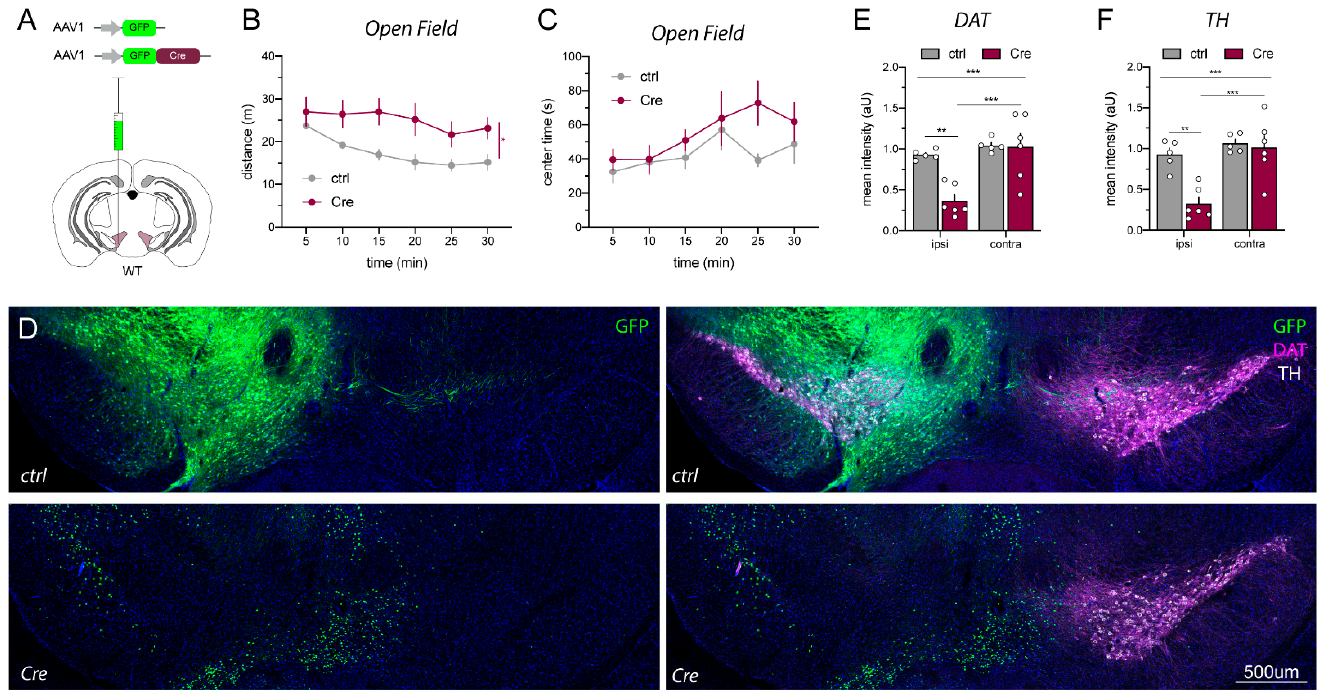
Figure 4. DAT and TH loss in the VTA of AAV1_Cre-GFP-injected WT mice coincide with hyperactivity. ( A ) Scheme visualizing unilateral injection of Cre (AAV1_Cre-GFP) and AAV1_GFP controls at 10 13 GC/mL into the VTA of adult WT C57BL/6J mice (for details see Figure S1). ( B , C ) Cre-injected WT mice become hyperactive compared to GFP control-injected mice in the open field (ctrl n = 5, Cre n = 6; mixed-effect analysis, distance: F(2.327,20.47) = 8.179, p = 0.4653 and genotype: p = 0.0465 *, center time: F(5,45) = 1.380, p = 0.2498 and genotype: p = 0.2969). ( D ) Immunostainings of unilaterally injected WT mice with either AAV1_GFP (ctrl; top panels) and AAV1_Cre-GFP (Cre; bottom panels) four weeks after injection. ( E , F ) Quantification revealed a massive loss of TH (white) and DAT (magenta) in the ipsilateral (ipsi, injected) side of Cre-injected mice compared to the contralateral (contra, non-injected) side and AAV1_GFP control-injected mice (ctrl n = 5, Cre n = 6; two-way ANOVA, DAT: F(1,9) = 12.12, p = 0.0006 ***; ipsi ctrl vs. Cre p = 0.0019 **; Cre ipsi vs. contra p = 0.0003 ***; TH: F(1,9) = 9.171, p = 0.0143 ***; ipsi ctrl vs. Cre p = 0.0011 **; Cre ipsi vs. contra p = 0.0006 ***). Scale bar 500 µm.